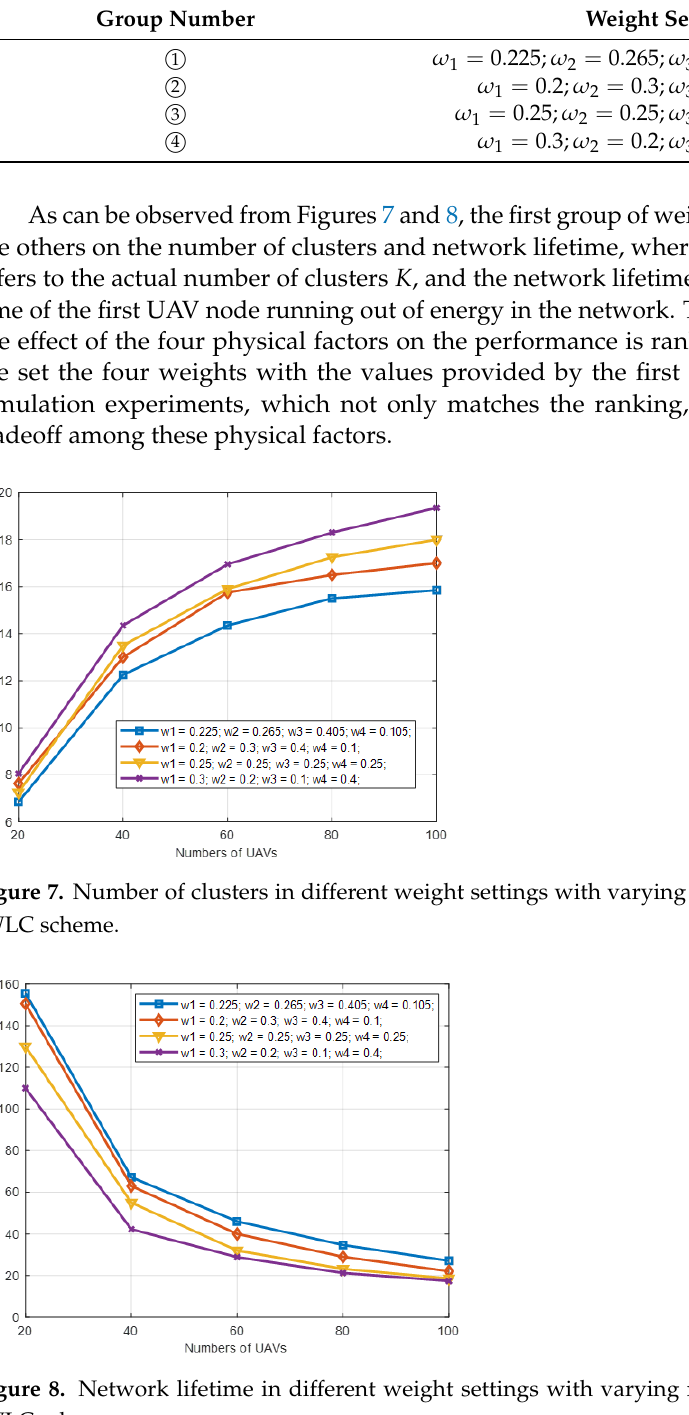
Table 4. Four sets of weight settings.